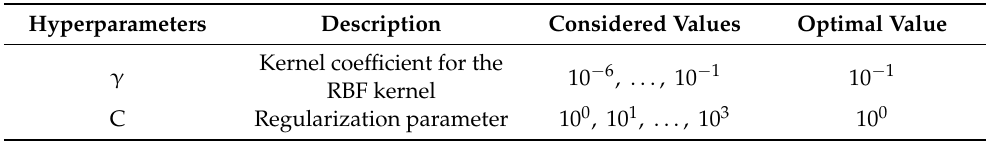
Table 4. Default value range and optimal value for two important hyperparameters of the SVM algorithm.